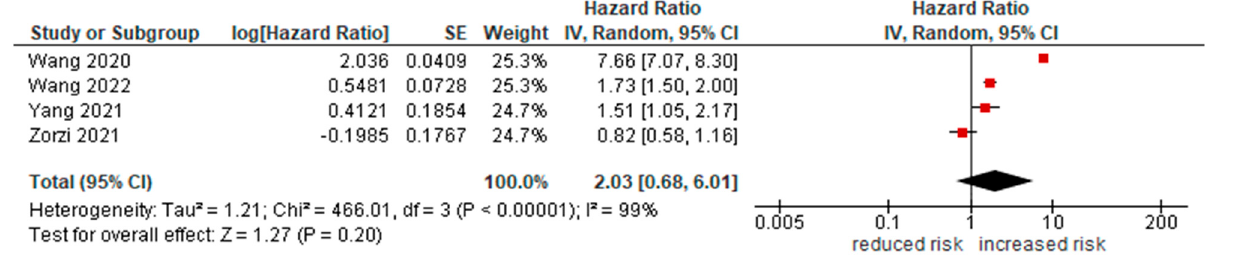
Figure 2. Forest plot for risk of infection in lung cancer patients.